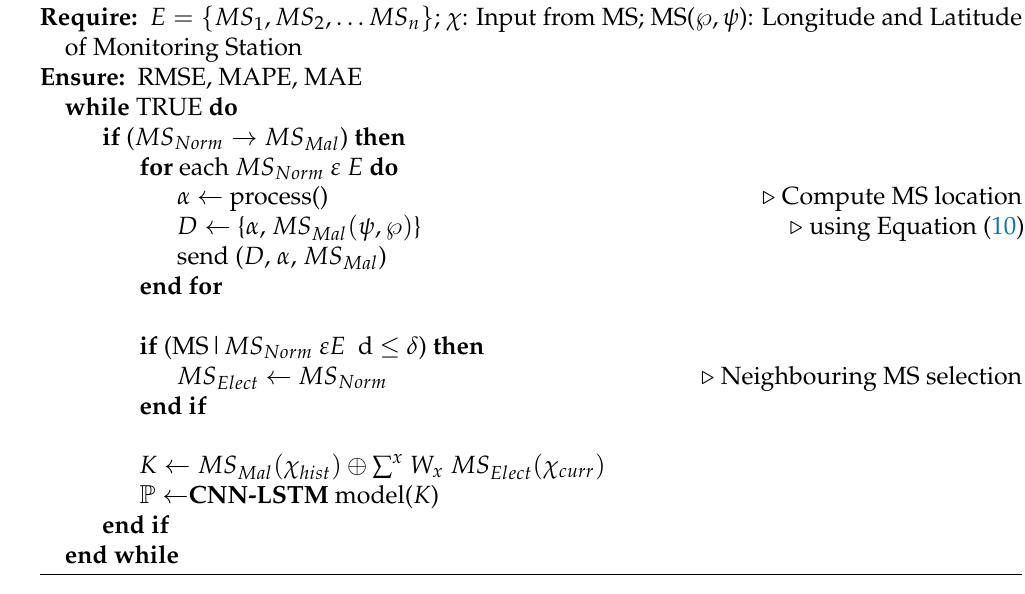
Algorithm 1 Fault-tolerant Monitoring Station